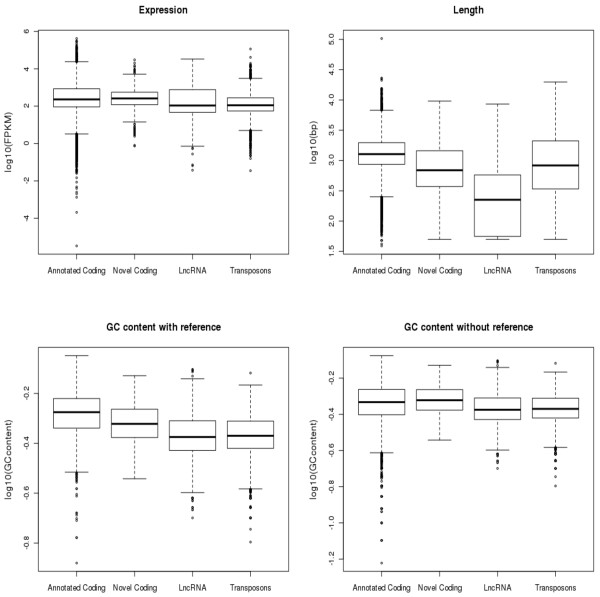
Expression levels according to annotation. a) Boxplots of expression level (log10 FKPM) for annotated coding genes, novel coding genes, lincRNA and transcripts with TE. The black line represents the median. b) Boxplots of the transcript unit length in base pairs (log10). c) Boxplots of the GC content (log10) using the reference annotation for transcriptome assembly. d) Boxplots of the GC content (log10) without using the reference annotation.